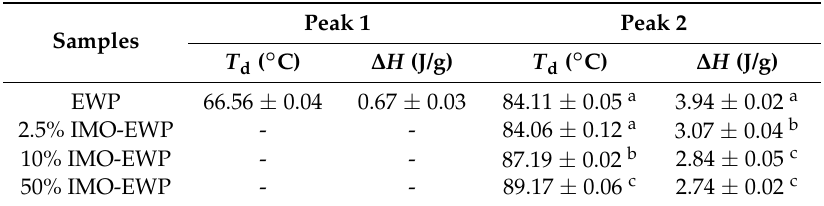
Figure 3. Differential Scanning Calorimetry (DSC) thermograms of EWP and IMO-EWP conjugates at pH 7.0. Table 1. DSC assessment of denaturation temperature ( T d ) and the associated enthalpy change ( ∆ H ) of EWP and IMO-EWP conjugates at pH